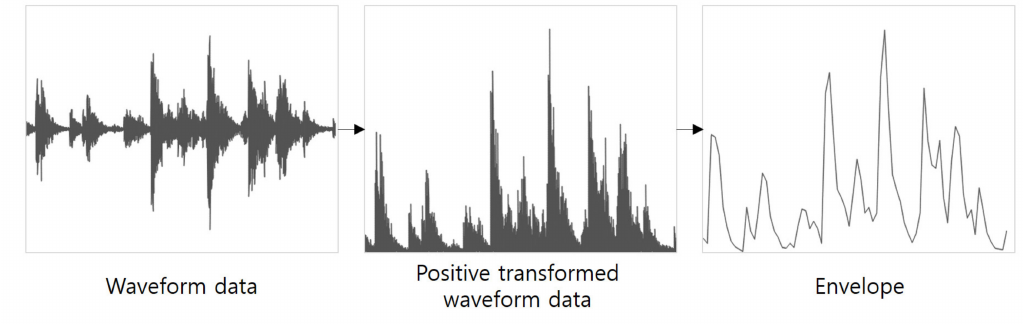
Figure 3. Process of converting raw